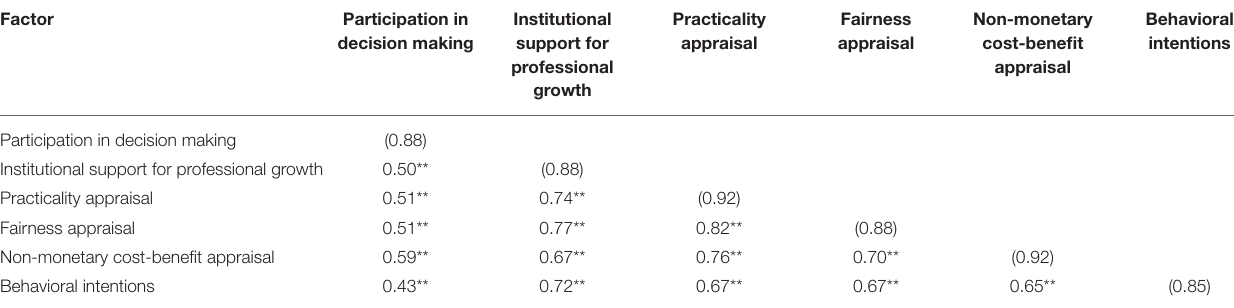
TABLE 2 | Discriminant validity of the subscales ( N =